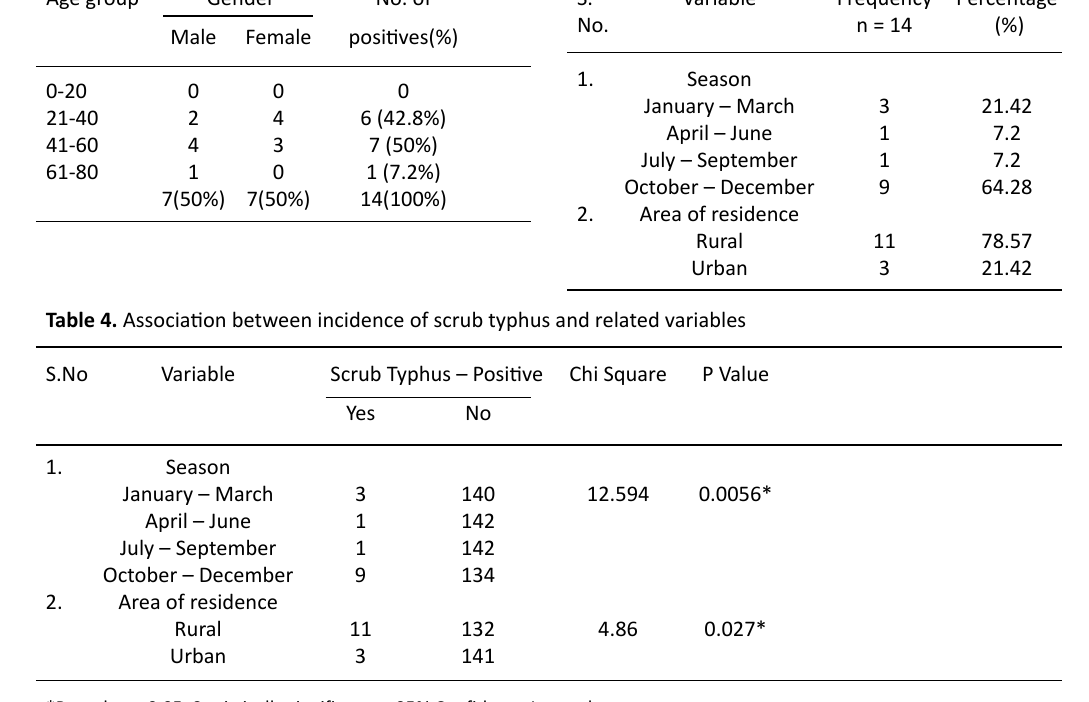
table 2. Gender wise distribution of positive scrub typhus samples by different age groups Age group Gender No. of